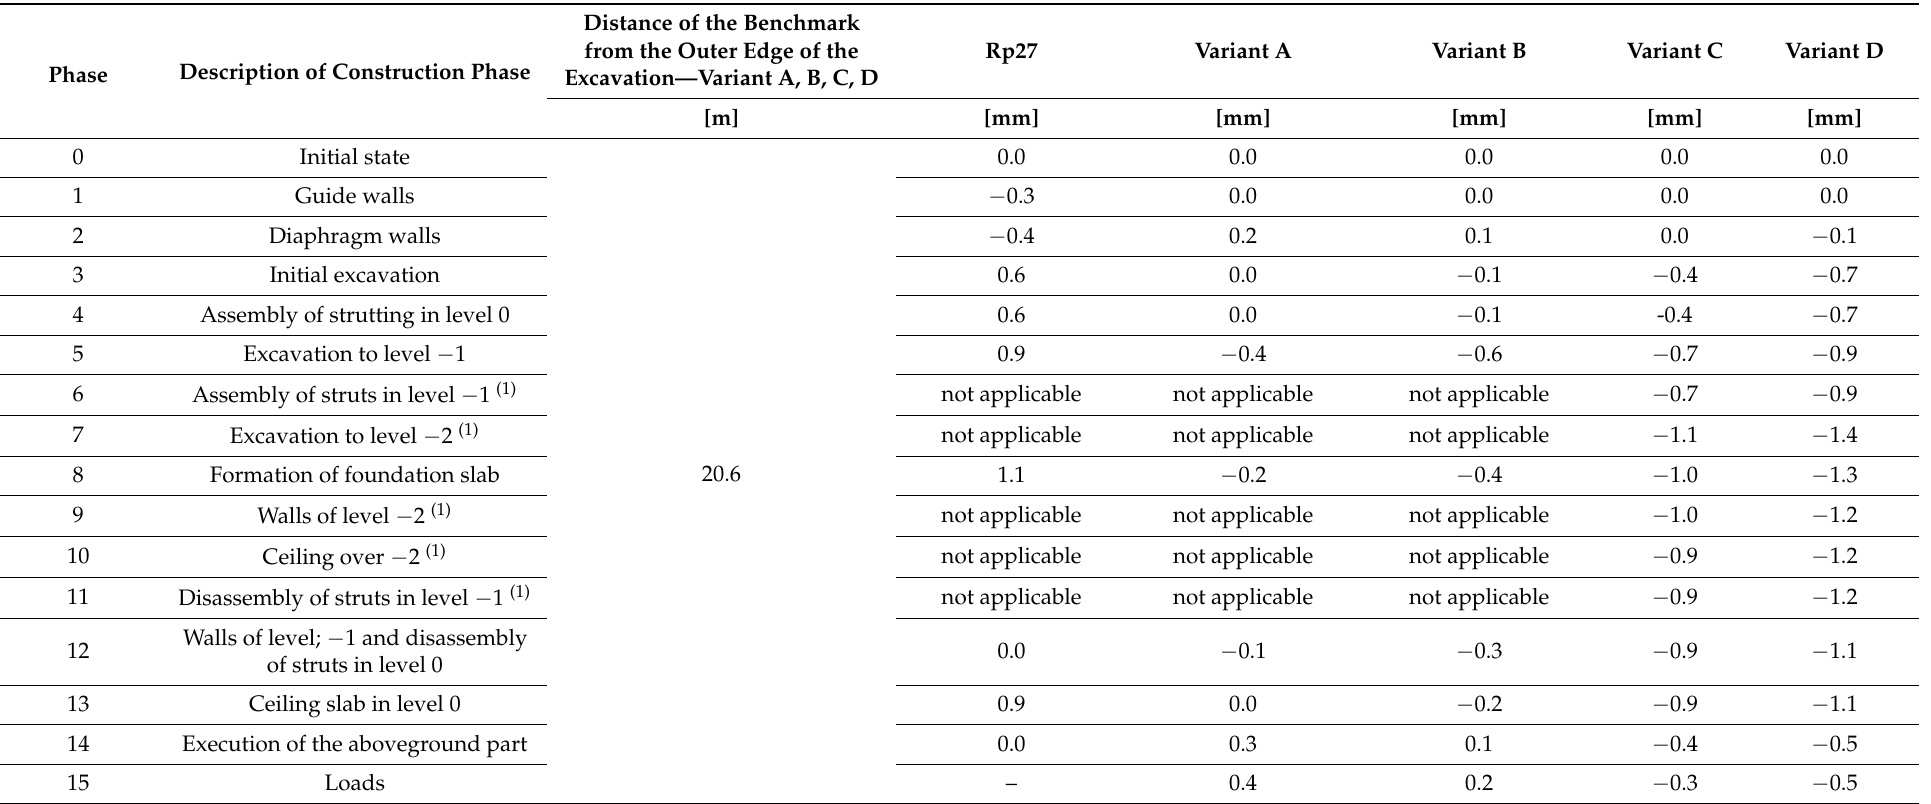
Table 2. Comparison of the results of geodetic measurements of vertical displacements of benchmark Rp27 situated on the eastern wall of the high-rise building at 1B Ludna Street in individual phases of investment implementation with the values of vertical displacements obtained from numerical